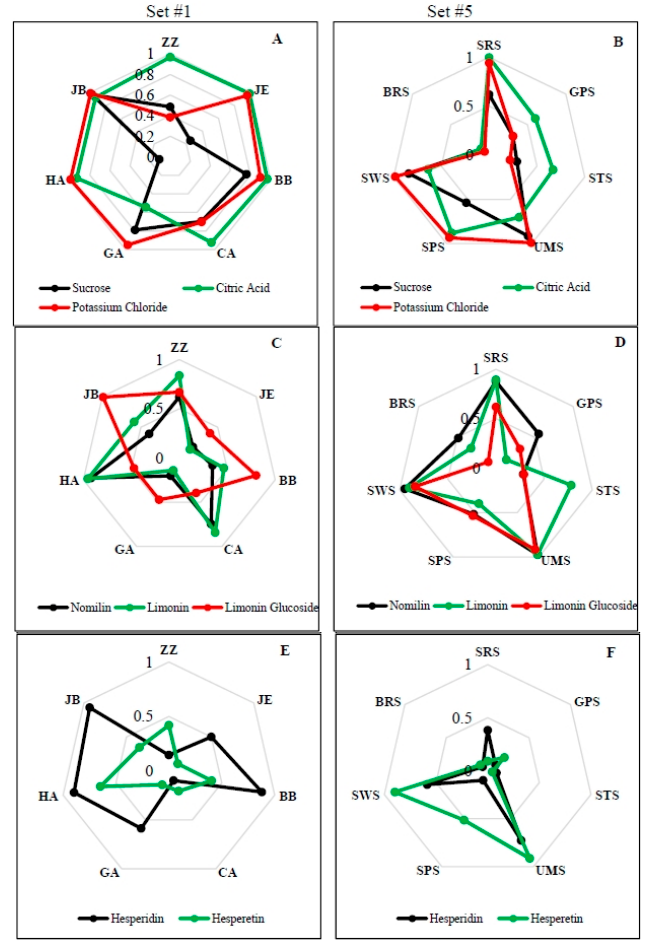
Figure 2. Radar plots showing discrimination power of the seven electronic tongue sensors, set #1 ( A , C , E ) and set #5 ( B , D , F ), for sucrose, citric acid, potassium chloride and nomilin, limonin, limonin glucoside, hesperidin, hesperetin.